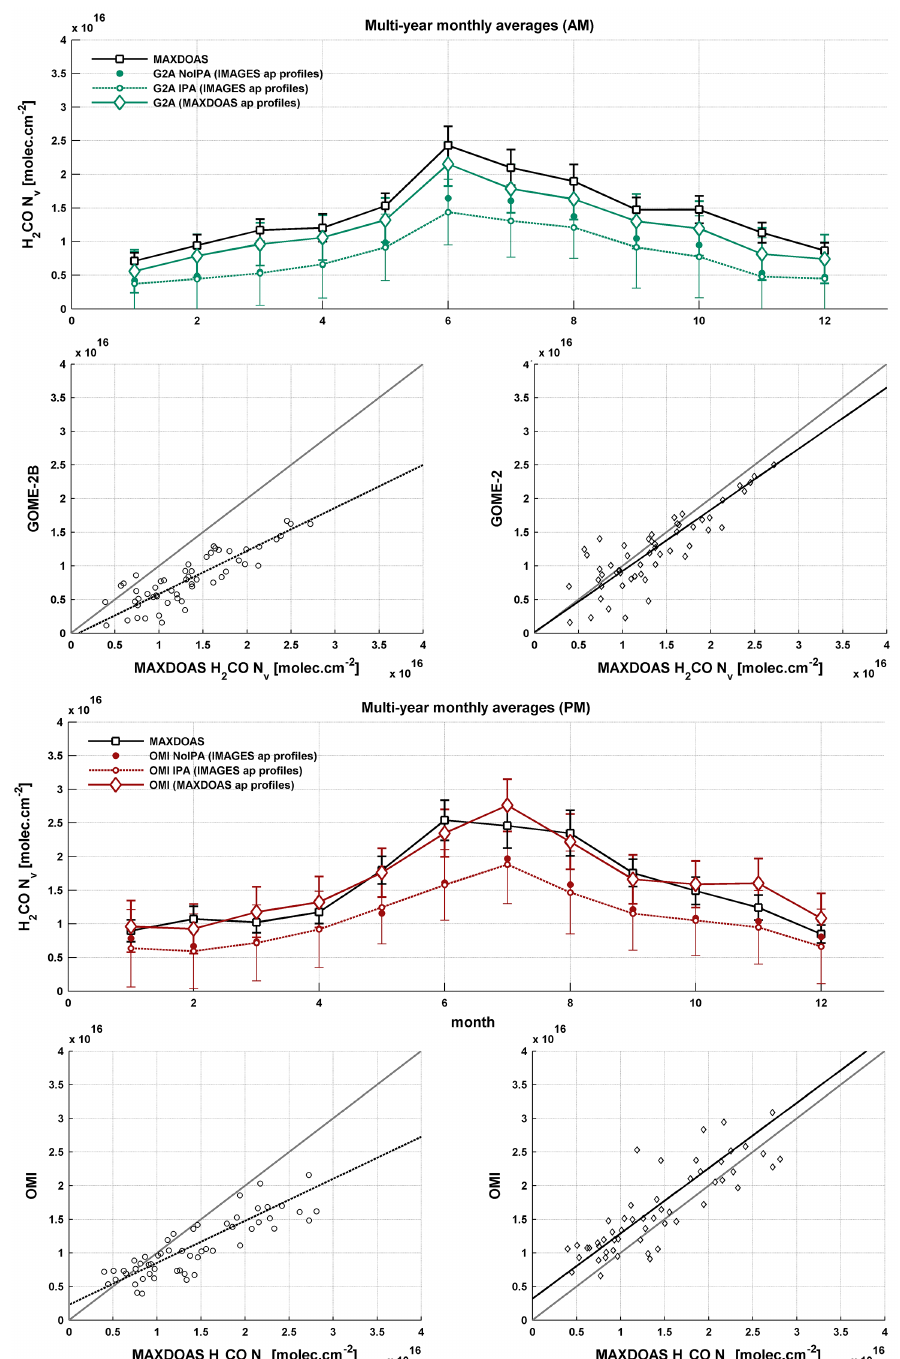
Figure 11. Validation of GOME-2 and OMI retrievals in Beijing and Xianghe, using MAX-DOAS retrievals (represented by black squares). Upper panel: mid-morning observations (GOME-2 and MAX-DOAS averaged over 8–11h). Lower panel: early afternoon observations (OMI and MAX-DOAS averaged over 12–15h). Observations have been averaged per month, over the period 2008–2013, selecting correlative days between GOME-2/OMI and the MAX-DOAS instrument. Satellite measurements have been averaged within 100km around each location, and filtered using quality criteria as defined in Sect. 3.4. Three satellite VCs are presented: IMAGES a.p. profile/no cloud correction, IMAGES a.p. profile/IPA cloud correction, and MAX-DOAS a.p. profile/IPA cloud correction. Correlation plots are shown for the two latter cases, respectively, in the left and right